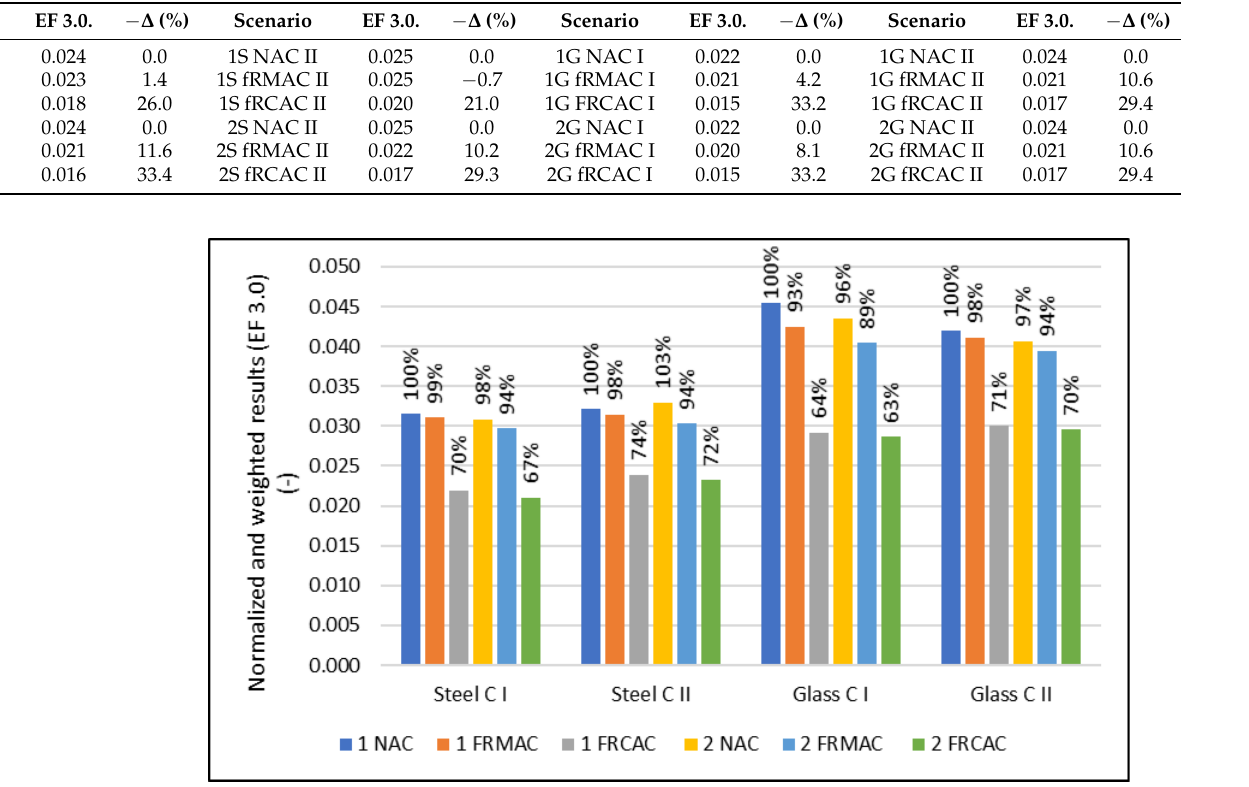
Figure 3. Normalized and weighted results for serviceability-oriented design scenarios (according to EF 3.0).